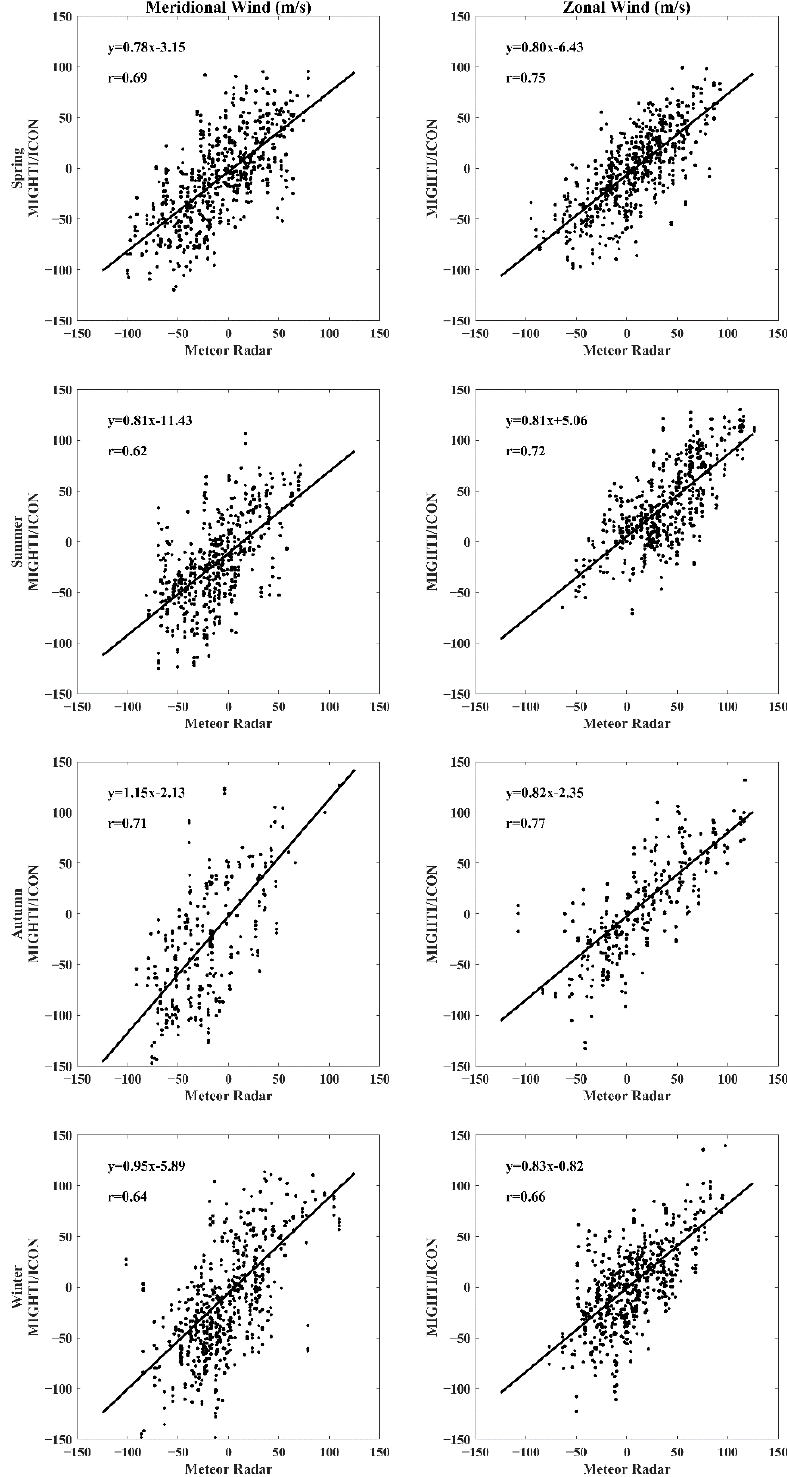
Figure 8. Scatter diagram of horizontal wind measurements from MIGHTI/ICON and meteor radar. The left side is meridional wind, and the right side is zonal wind. From top to bottom: Spring (January, February, and March), summer (April, May, and June), autumn (July, August, and September), and winter (October, November, and December).